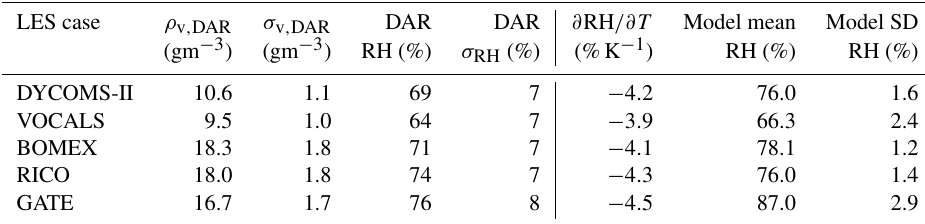
Table 3. Estimating near-surface water vapor density ( ρ v , DAR ) and RH using the cloud-to-surface partial-column DAR humidity measure- ment. Reported DAR RH values assume perfect knowledge of surface temperature, and sensitivity to this assumption is quantified by the term ∂ RH /∂T . Note that for the GATE case, the partial column often extends well into the middle and upper troposphere, and therefore the inferred surface RH is highly dependent on the assumed sub-cloud humidity profile shape. For all other cases, a well-mixed PBL is assumed for the shallow sub-cloud